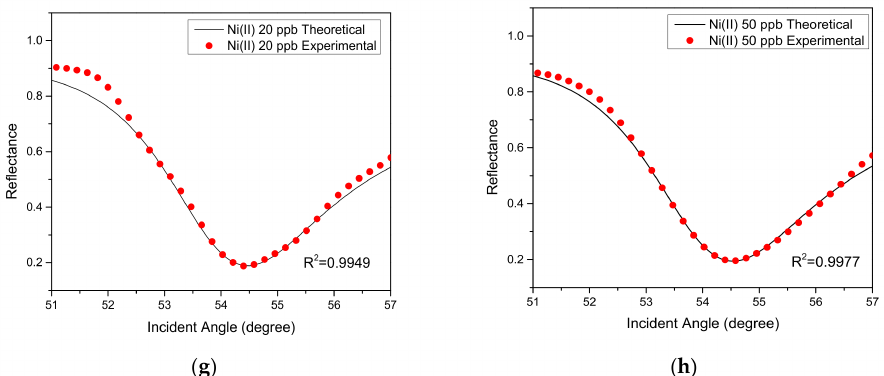
Figure 4. Fitting experimental data to theoretical data for Au/MPA/V–CNCs–CTA thin film when detecting ( a ) DW and ( b ) 2 ppb; ( c ) 4 ppb; ( d ) 6 ppb; ( e ) 8 ppb; ( f ) 10 ppb; ( g ) 20 ppb; ( h ) 50 ppb of Ni(II) ion solution.